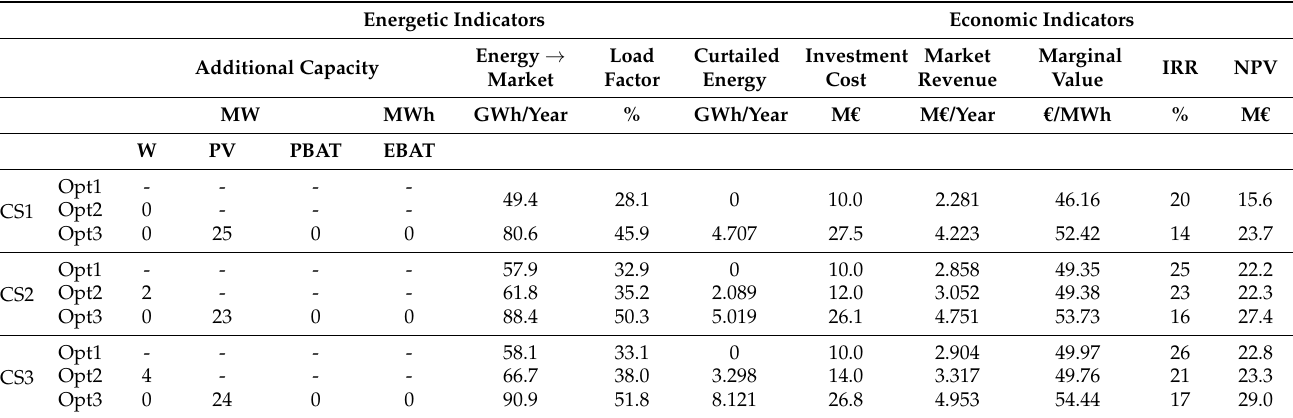
Table 4. Results of the optimal design for the hybrid renewable power plant (HRPP) for the three case